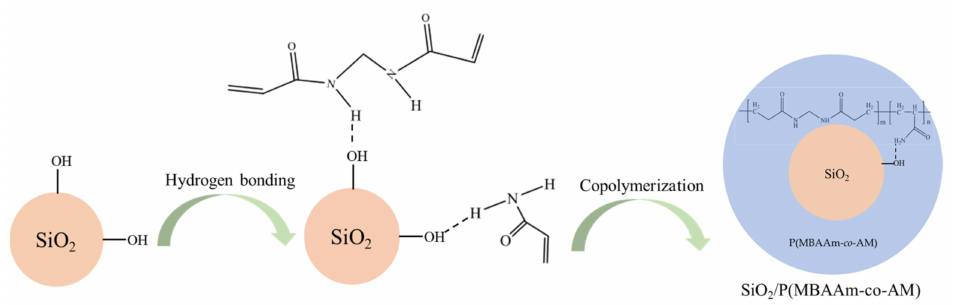
Figure 1. Schematic illustration of the synthetic process of the SiO 2 /P(MBAAm- co -AM) polymeric